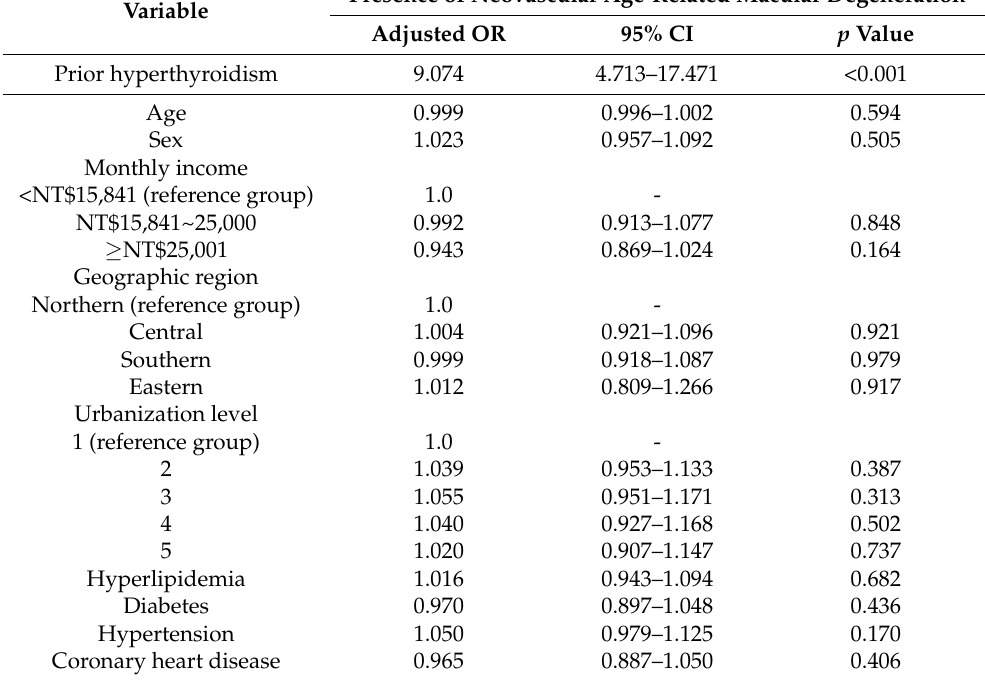
Table 3. Covariate-adjusted odds of prior hyperthyroidism (OR and 95% confidence interval, CIs) among neovascular age-related macular degeneration vs. controls ( n = 15,044).